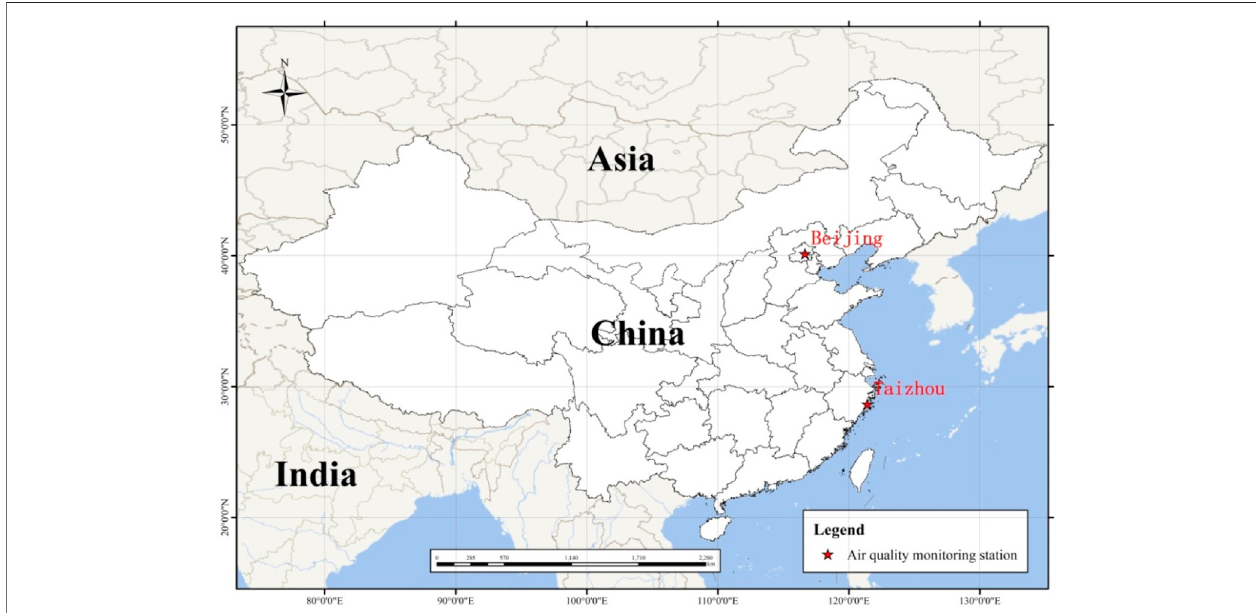
FIGURE 1 | The location of Beijing and Taizhou air quality monitoring stations in China.